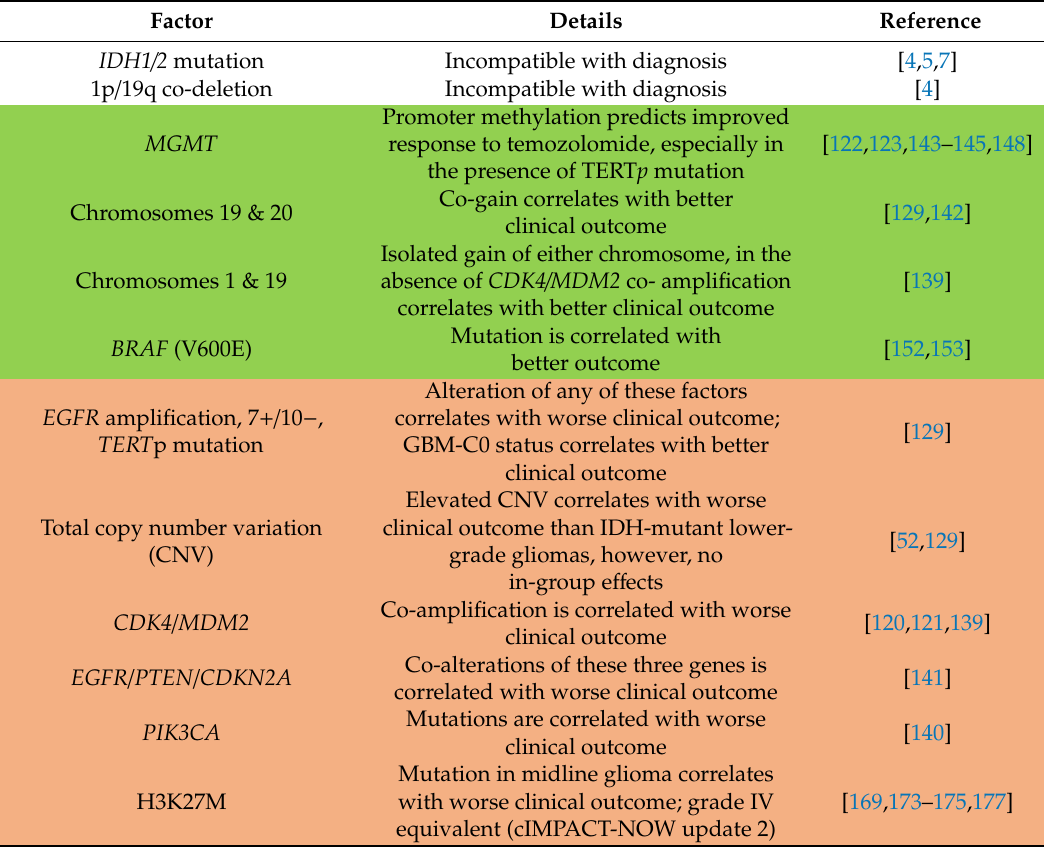
Table 5. Prognostic factors in IDH-wildtype